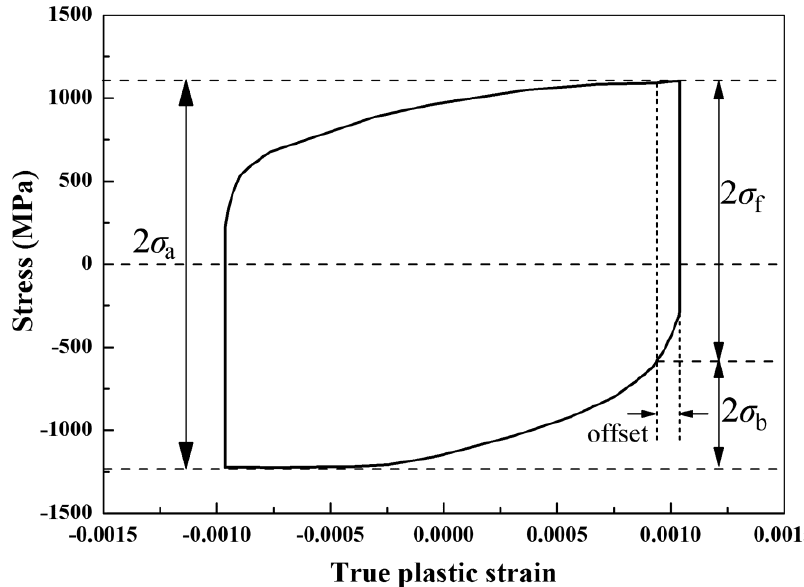
Figure 2. Determination of the effective stress and the internal stress from fatigue hysteresis loops by KWLC technique. The hysteresis loop data are taken from the fifth cycle of the DA samples under the total strain amplitude of 2%.